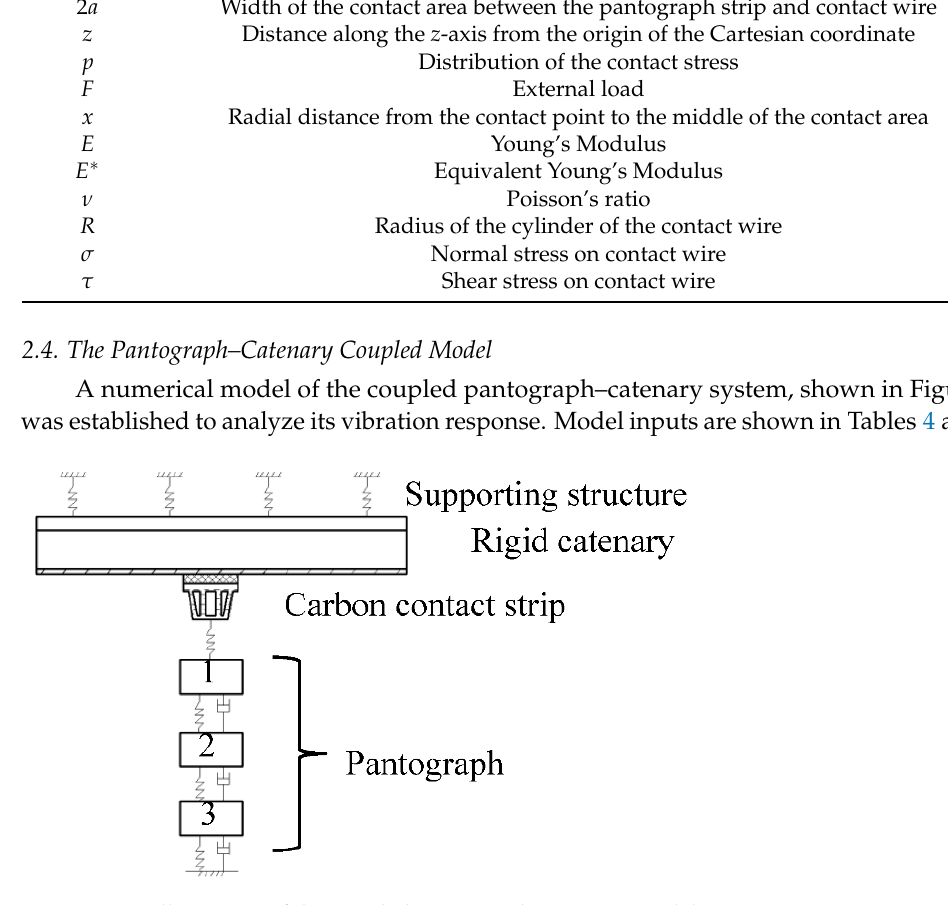
Figure 8. An illustration of the coupled pantograph–catenary model. Table 4. Parameter input of the rigid catenary and the pantograph strip.